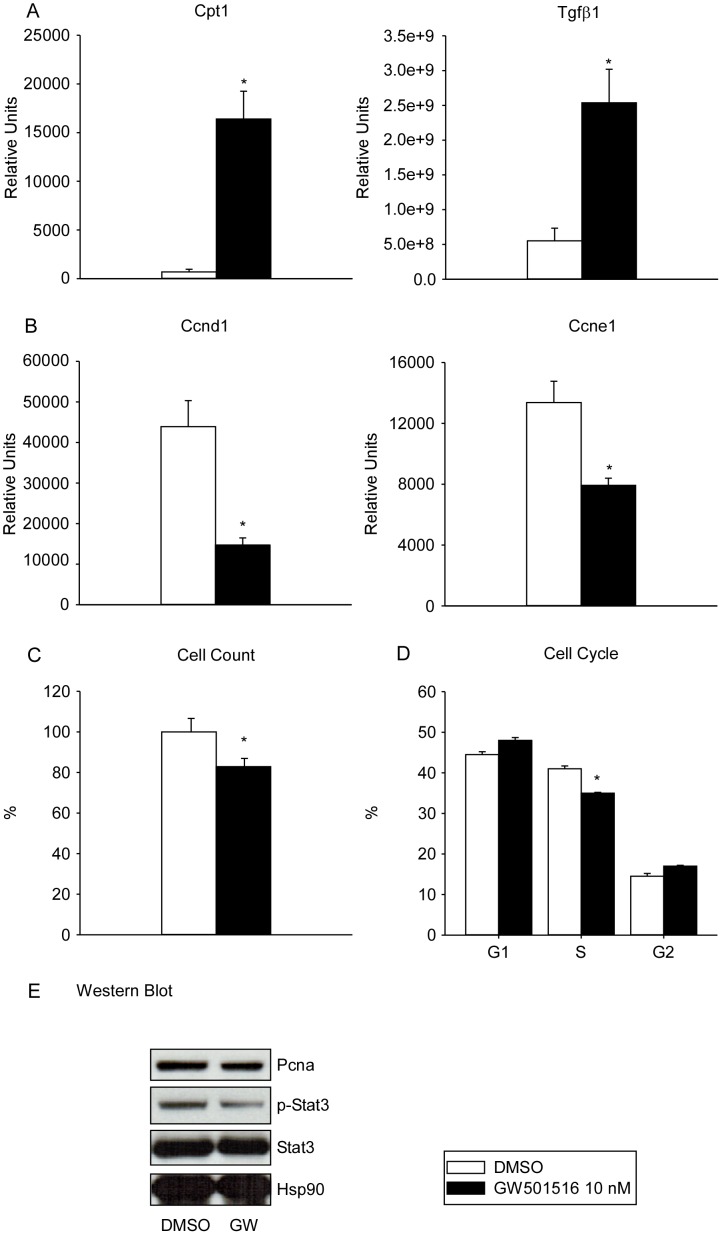
PPARβ/δ agonist GW501516 reduces Hepa 1-6 proliferation.Hepa 1–6 cells were treated with PPARβ/δ agonist GW501516 (10 nM) for 48 h. The efficacy of GW501516 in activating Pparβ/δ was confirmed at the mRNA level (A, relative mRNA expression of the Pparβ/δ target genes Cpt-1 and TGFβ1). When compared to the DMSO treated cells, the proliferative response of Hepa 1–6 treated with GW501516 was reduced, as confirmed by relative mRNA expression of Ccnd1 and Ccne1 (B), cell count (C), S-Phase at the analysis of the cell cycle (D), Pcna protein expression and Stat-3 phosphorylation (E, Western blot). For mRNA expression, Gapdh was used as reference gene, and values were expressed as relative units. All the results are shown as mean ± SEM. Asterisks indicate statistical significance (p≤0.05), assessed by the unpaired Mann-Whitney rank sum test (triplicate/group).